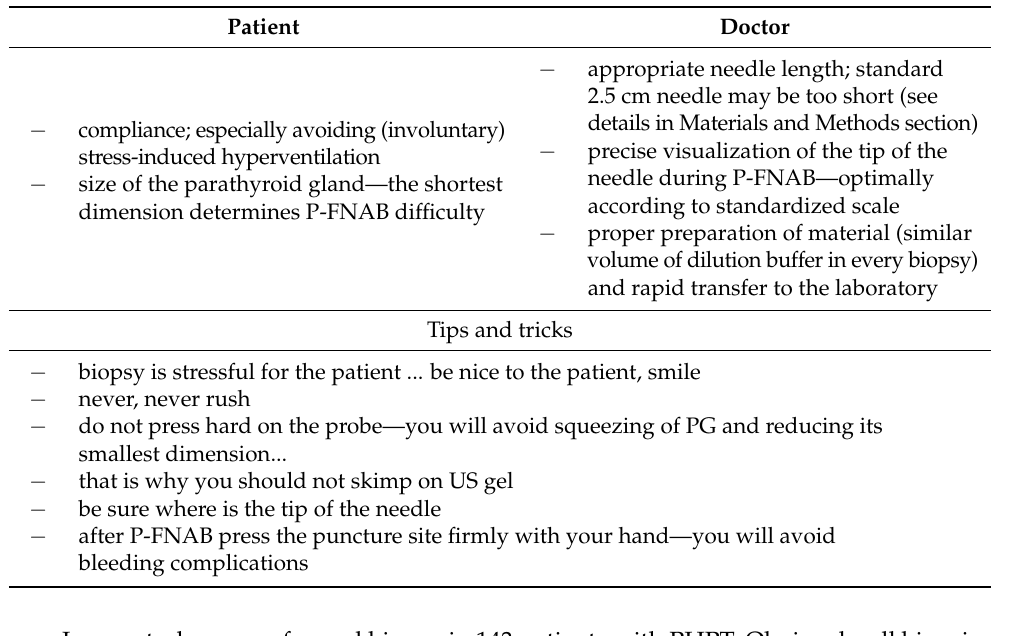
Table 4. Technical approach and tips and tricks necessary to perform successful